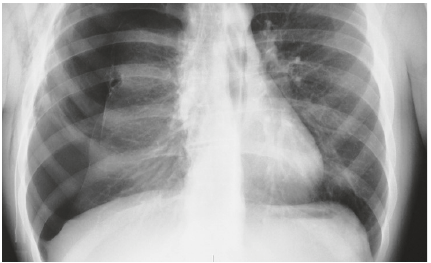
Figure 1: Operating theater chest X-ray with right pneumothorax.